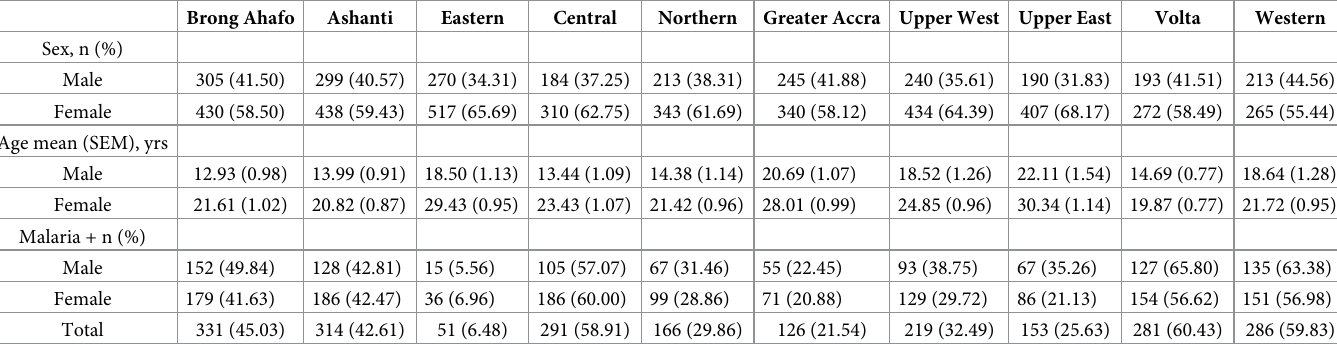
Table 1. Demographic characteristics of study